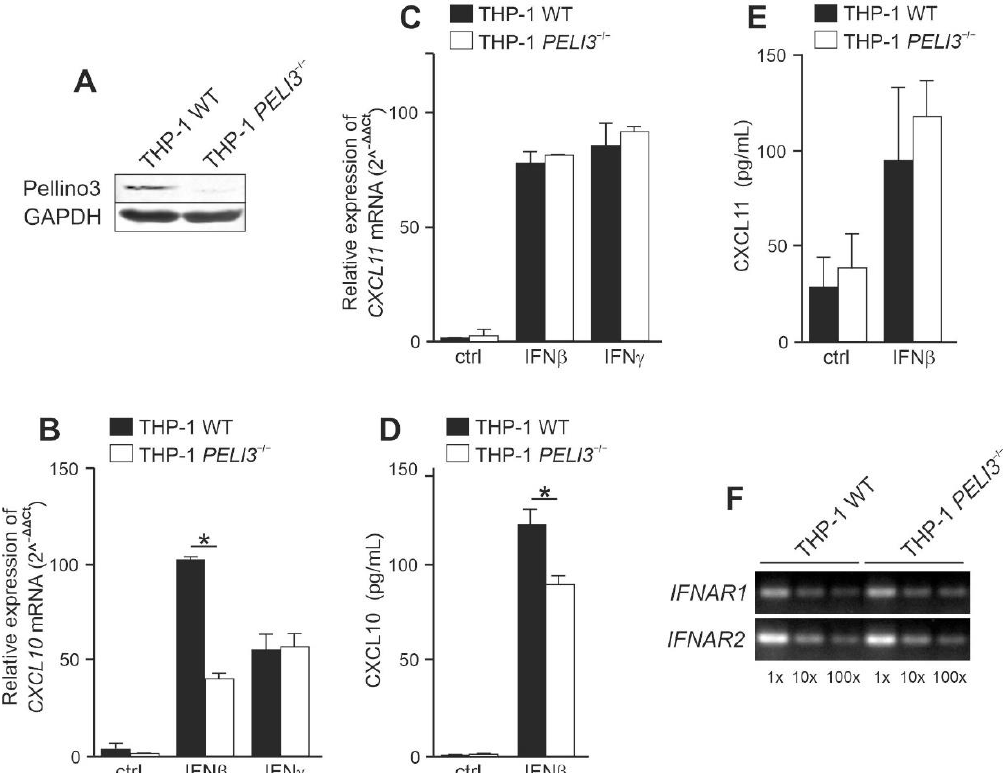
Figure 1. INFβ -dependent CXCL10 induction is downregulated in Pellino3 deficient THP-1 cell line. ( A ) Pellino3 knockout in THP-1 cells was generated using Guide-it CRISPR/Cas9 Gesicle Production System (Takara Bio) according to the manufacturer’s instruction. Cell lysates from WT and PELI3 −/− THP-1 were subjected to SDS-PAGE followed by Western blotting. Protein detection was performed using specific antibodies and appropriate secondary antibodies conjugated to the fluorescent dye in the infrared range. Visualization was performed using the Odyssey CLx Imaging System LI-COR. Wild type (WT) and PELI3 −/− THP- 1 cells were treated with IFNβ (1000 U/mL) or IFNγ (15 ng /mL) for 4 h ( B , C ) or 16 h ( D , E ). ( B , C ) Thereafter, total RNA was isolated and reverse transcribed. Quantitative real-time PCR (2 –(ΔΔCT) ) was used to assay the expression levels of CXCL10 and CXCL11 . Relative expression values were normalized to the HPRT1 reference gene and non-treated cells were assigned an arbitrary value of 1. ( B , D ) CXCL10 and CXCL11 level was measured by ELISA. ( F ) Total RNA was isolated from WT and PELI3 −/− THP-1 cells and converted to first-strand cDNA. This was used as a template for PCR amplifying genes as indicated. Products were resolved on 1.5% ( w/v ) agarose gel electrophoresis. All results presented are representative of at least three independent experiments. * p ≤ 0.01 (unpaired Student’s t -test) .